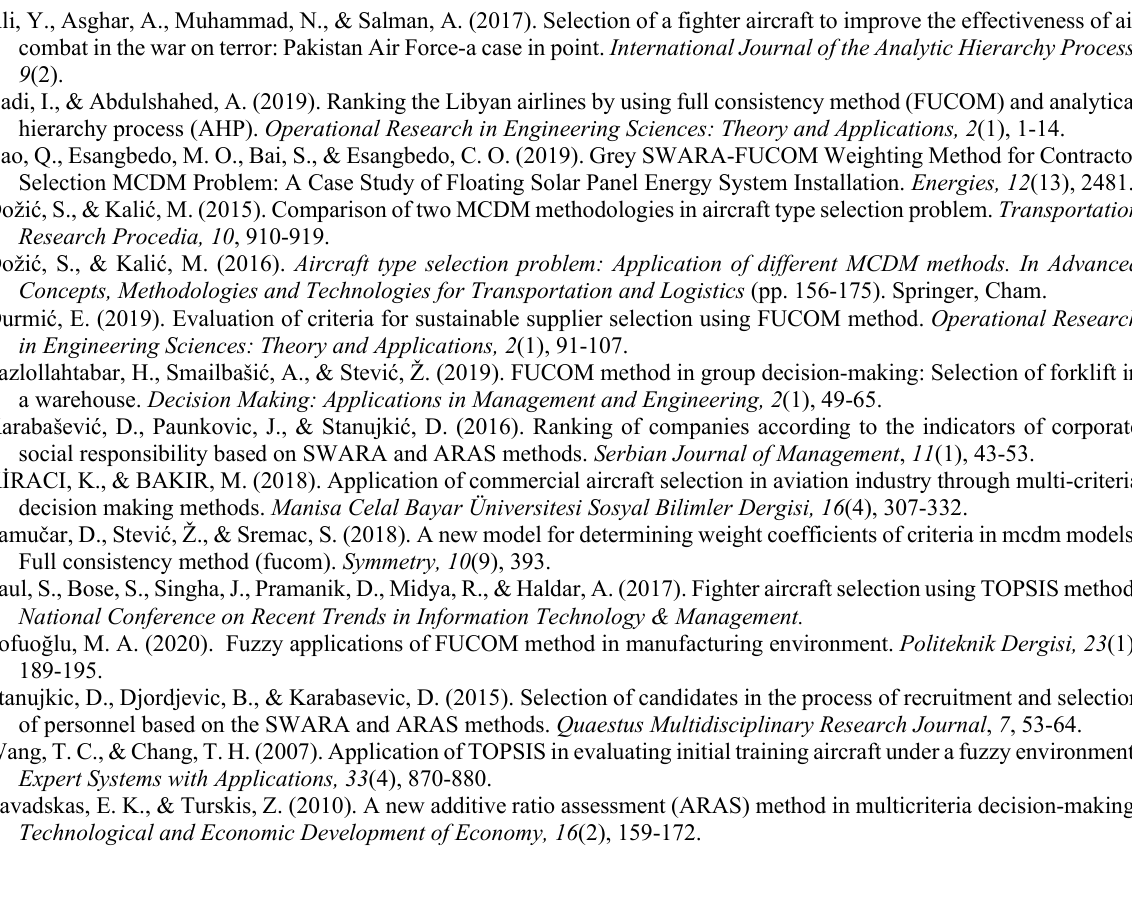
Fig. 2. Comparing the result of ARAS and